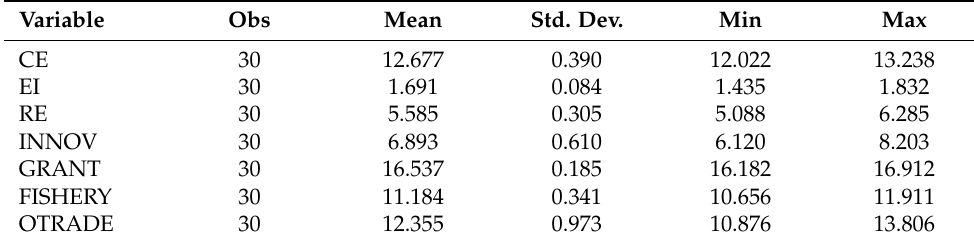
Table 2. Summary of